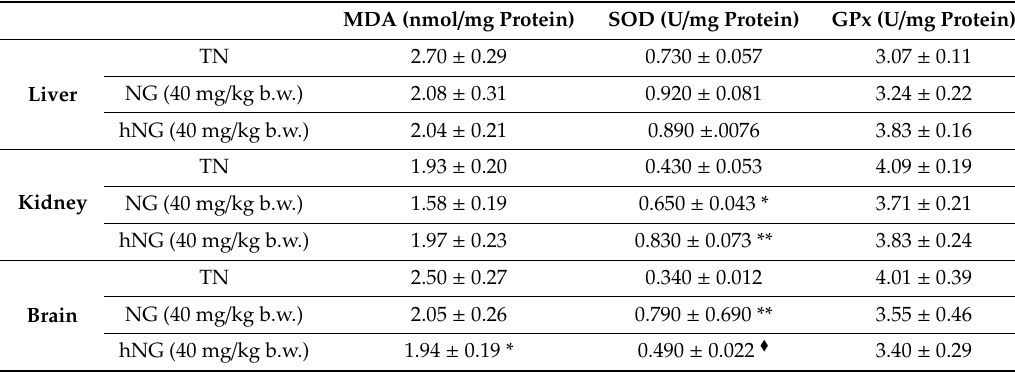
Table 4. Malondialdehyde (MDA), superoxide dismutase (SOD) and glutathione peroxidase (GPx) levels in liver, kidney, and brain homogenates from mice treated by naringin (NG) or heated naringin (hNG) and control groups